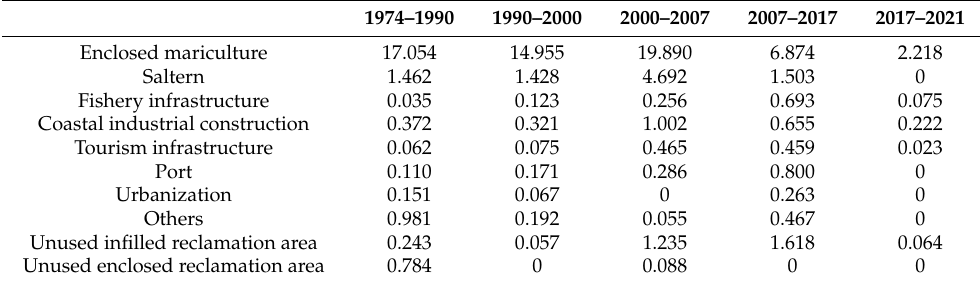
Table 4. Statistics on the rate of natural coastline occupation by different reclamation activities (Unit: km/a).